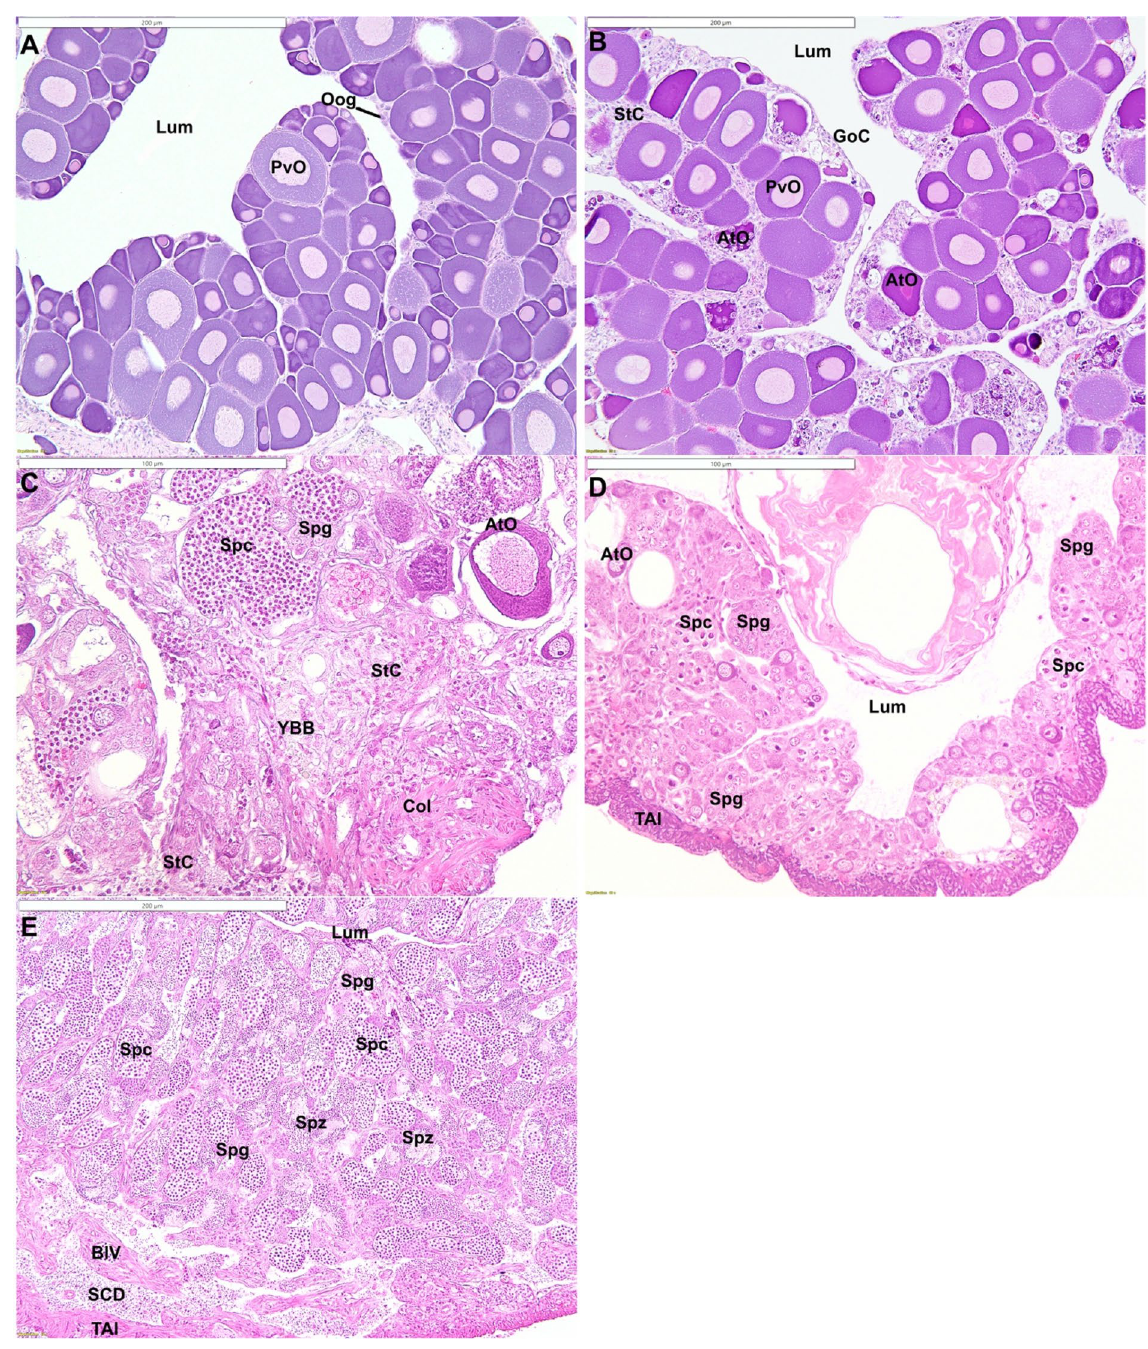
Figure 3. Histological stages of gonadal development in spotty wrasse: ( A ) female; ( B ) early transitioning fish; ( C ) mid-transitioning fish; ( D ) late transitioning fish; ( E ) terminal phase male. AtO atretic oocyte, BlV blood vessel, Col collagen, GoC gonial cells, Lum gonadal lumen, PvO previtellogenic oocyte, Oog oogonia, StC stromal cells, SCD sperm collecting duct, Spc spermatocytes, Spg spermatogonia, Spz spermatozoa, TAl tunica albuginea, YBB yellow–brown body consistent with melanomacrophage centres. Scale bars in A, B, E = 200 µm; C, D = 100